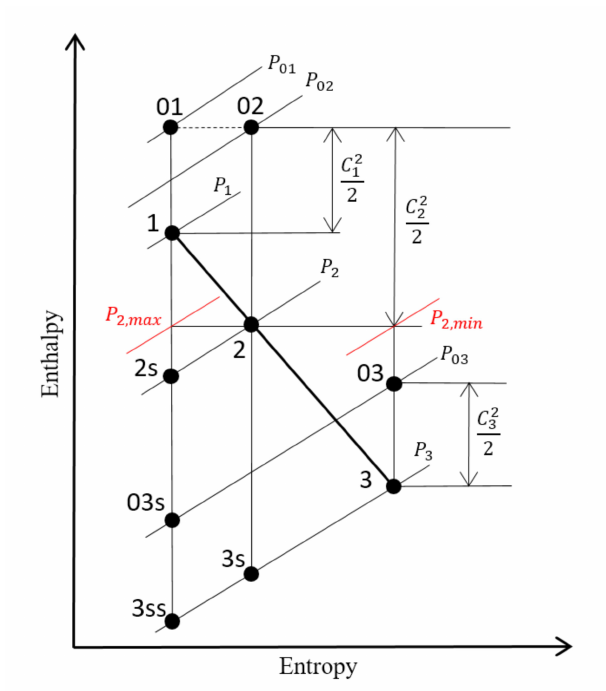
Figure 3. Enthalpy–entropy diagram of a radial outflow